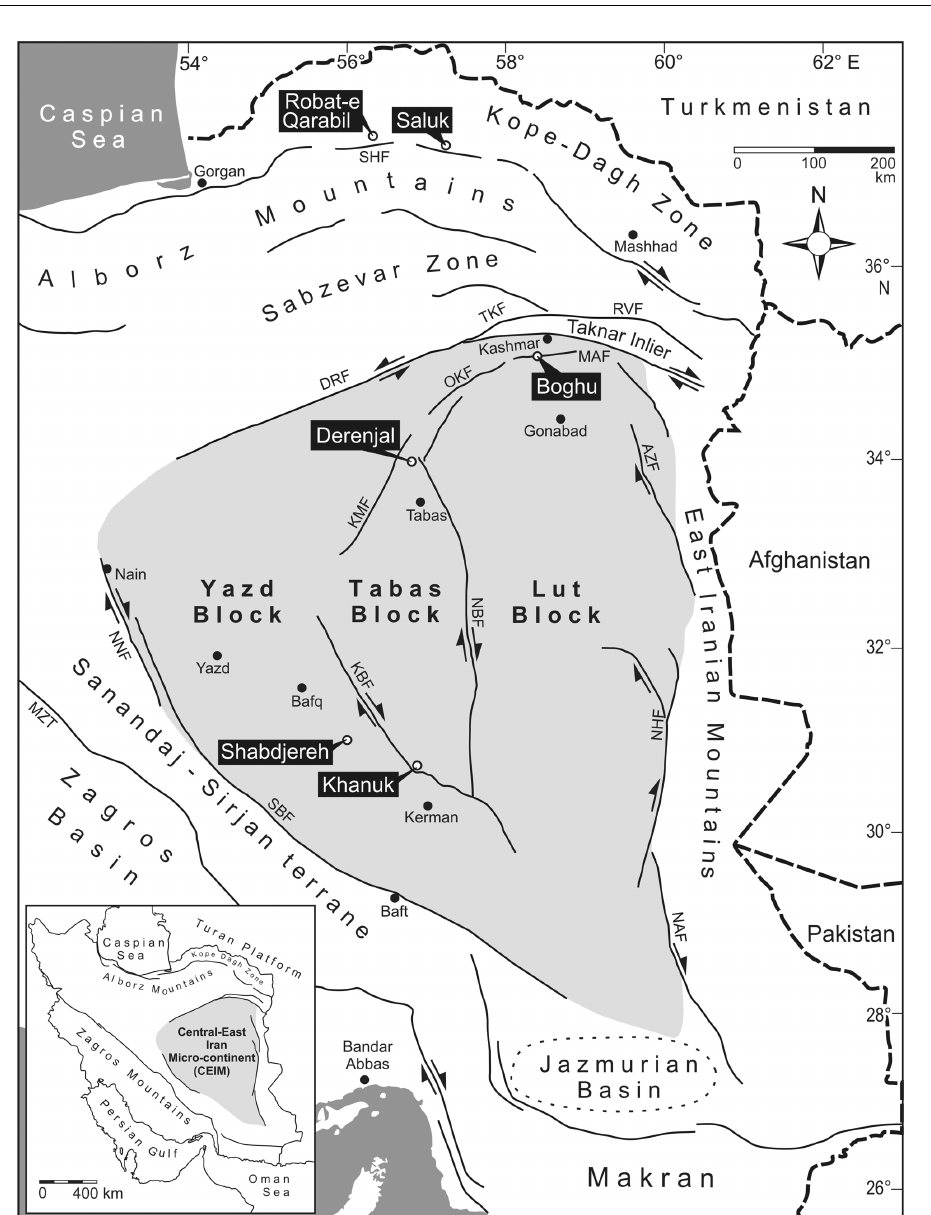
Fig. 1. Map of Iran showing Silurian brachiopod fossil localities discussed in the paper (mainly after Ramezani & Tucker 2003, with modifications; structural data compiled from various sources, e.g. Berberian & King 1981; Lindenberg et al. 1984; Alavi 1991; GSI 2001b; Ramezani & Tucker 2003). Abbreviations: AZF, Abiz fault; DRF, Doruneh fault; KBF, Kuhbanan fault; KMF, Kalmard fault; MAF, Mehdiabad fault; MZT, Main Zagros thrust; NAF, Nostratabad fault; NBF, Nayband fault; NHF, Nehbandan fault; NNF, Nain fault; OKF, Ozbak Kuh fault; RVF, Rivash fault; SBF, Shahre-Babak fault; SHF, Syahkuh fault; TKF, Taknar